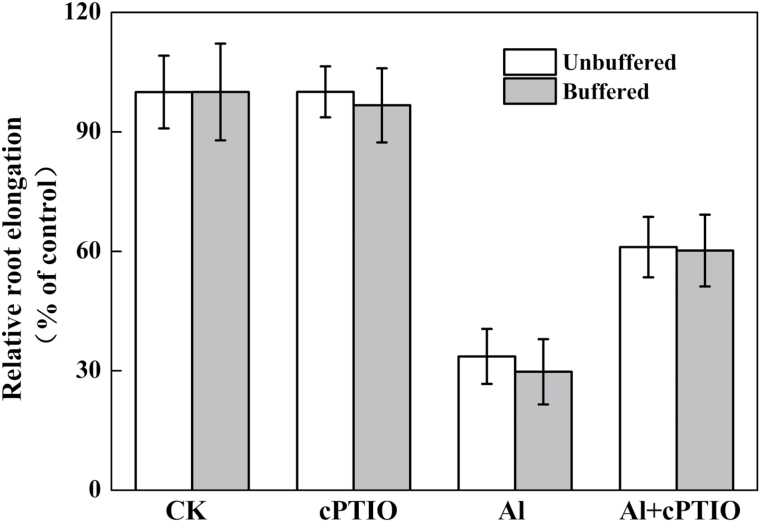
Effect of the NO scavenger cPTIO on Al-induced root growth inhibition. Three-day-old seedlings were exposed to 0.5mM CaCl2 solution containing 0 or 30 μM Al with or without 10mM MES in the presence or absence of 30 μM cPTIO for 24h. The pH was adjusted to 4.3. Means ± SD (n = 20).